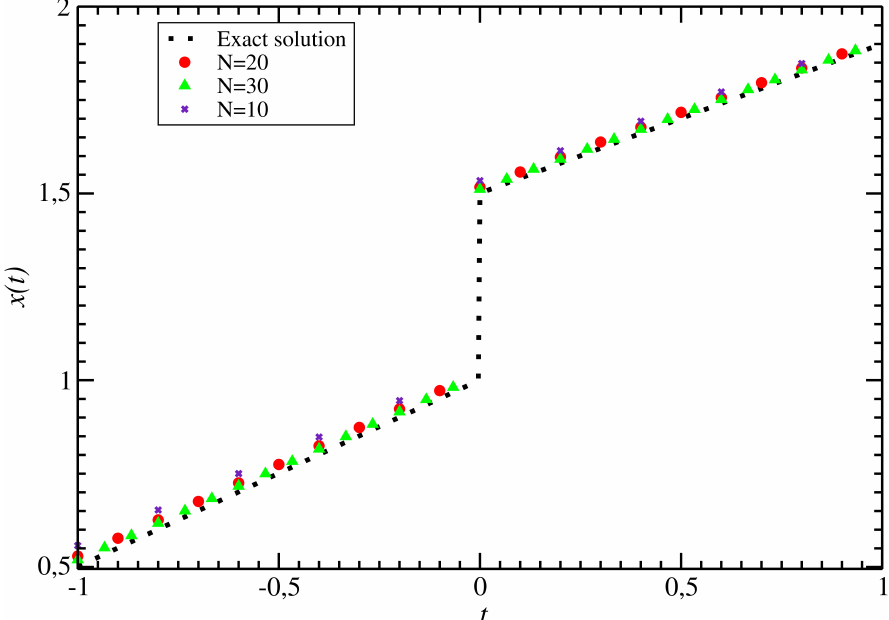
Figure 1. Numerical solutions for the linear hypersingular equation with a discontinuous right-hand side